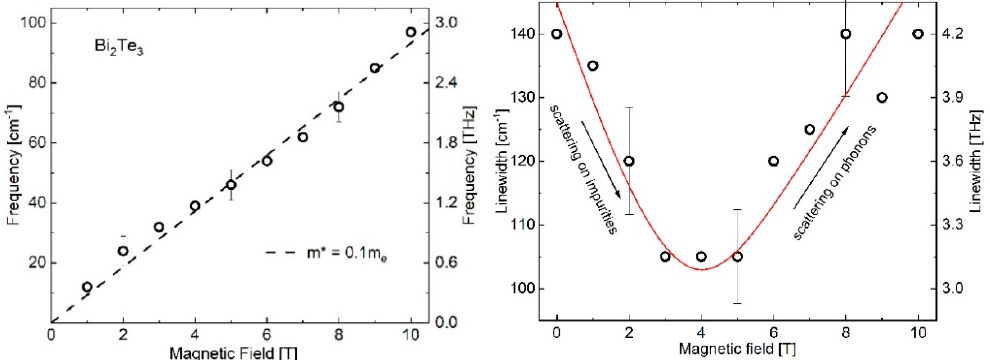
Figure 4. CR-line central frequency (left frame) and full width at half maximum (FWHM) (right frame) versus applied magnetic field. The dashed line is a fit with m * = 0.1 m e . The red solid line is a guide for the eye.